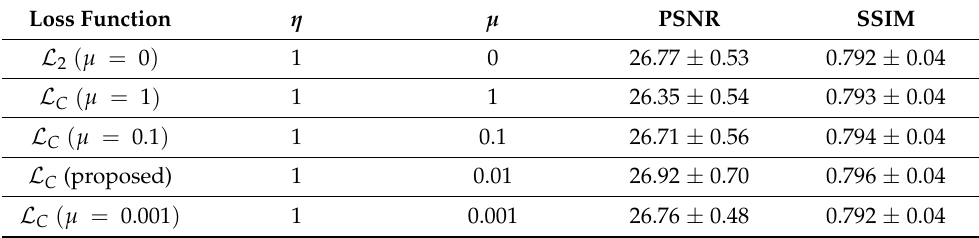
Table 4. Quantitative comparison of the loss function based on the LUSwin